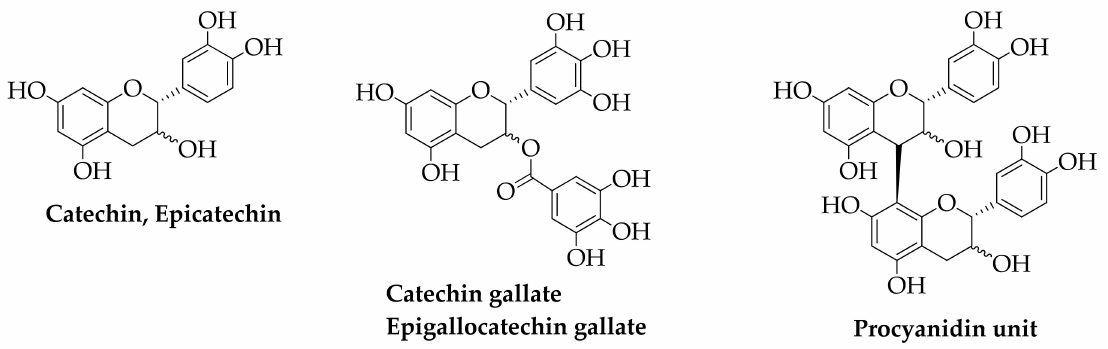
Figure 10. Flavan-3-ols and Proanthocyanidin